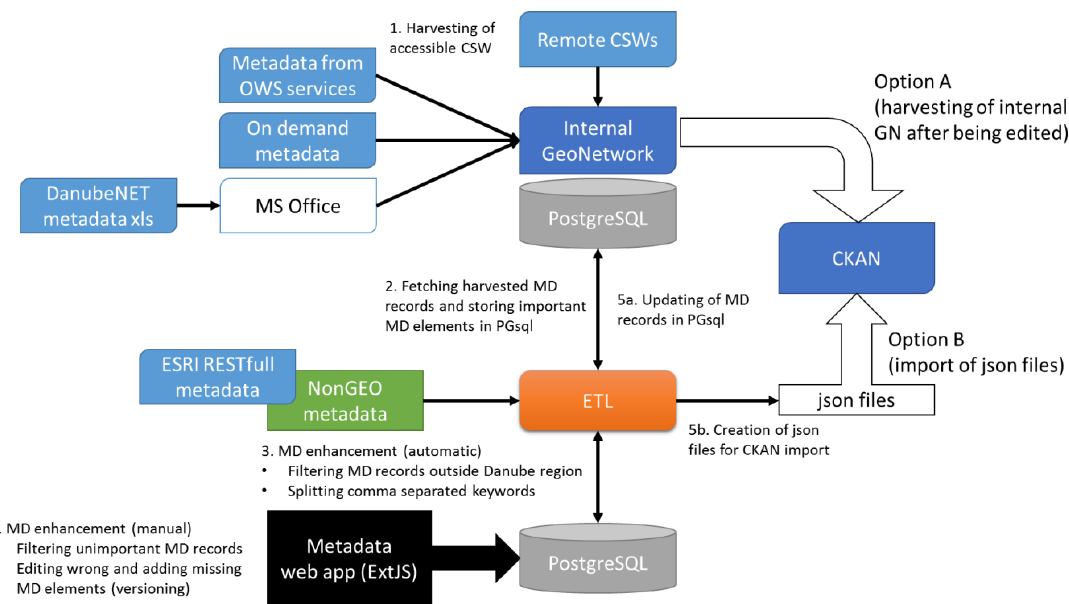
Figure 3. Architecture of the Danube Reference Data and Services infrastructure. Source: